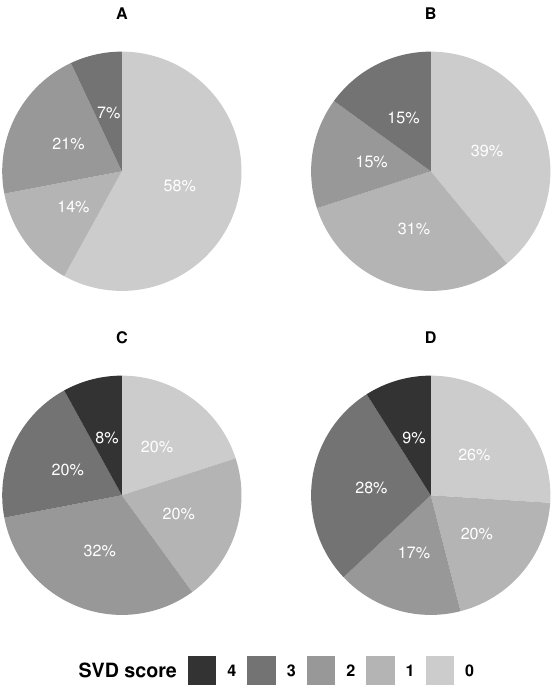
Figure 1. Distribution of the SVD score across TOAST groups. CE: cardioembolism; LAA: large artery Figure1. DistributionoftheSVDscoreacrossTOASTgroups. CE:cardioembolism;LAA:largeartery atherosclerosis;SVO:smallvesselocclusion;UD:undeterminedetiology. atherosclerosis; SVO: small vessel occlusion; UD: undetermined Carotid stenosis 50% was associated with TOAST classification ( p = 0.023) because ≥ these patients per definition belong to the LAA group, if not the UD. However, carotid stenosis was found across all TOAST groups (Table 1). Patients in the CE, SVO, and OD groups had stenosis on the non-relevant side. Carotid atherosclerosis was present in all TOASTgroups( p =0.35),butfive(47%)ofthepatientsintheLAAhadsevereatherosclerosis